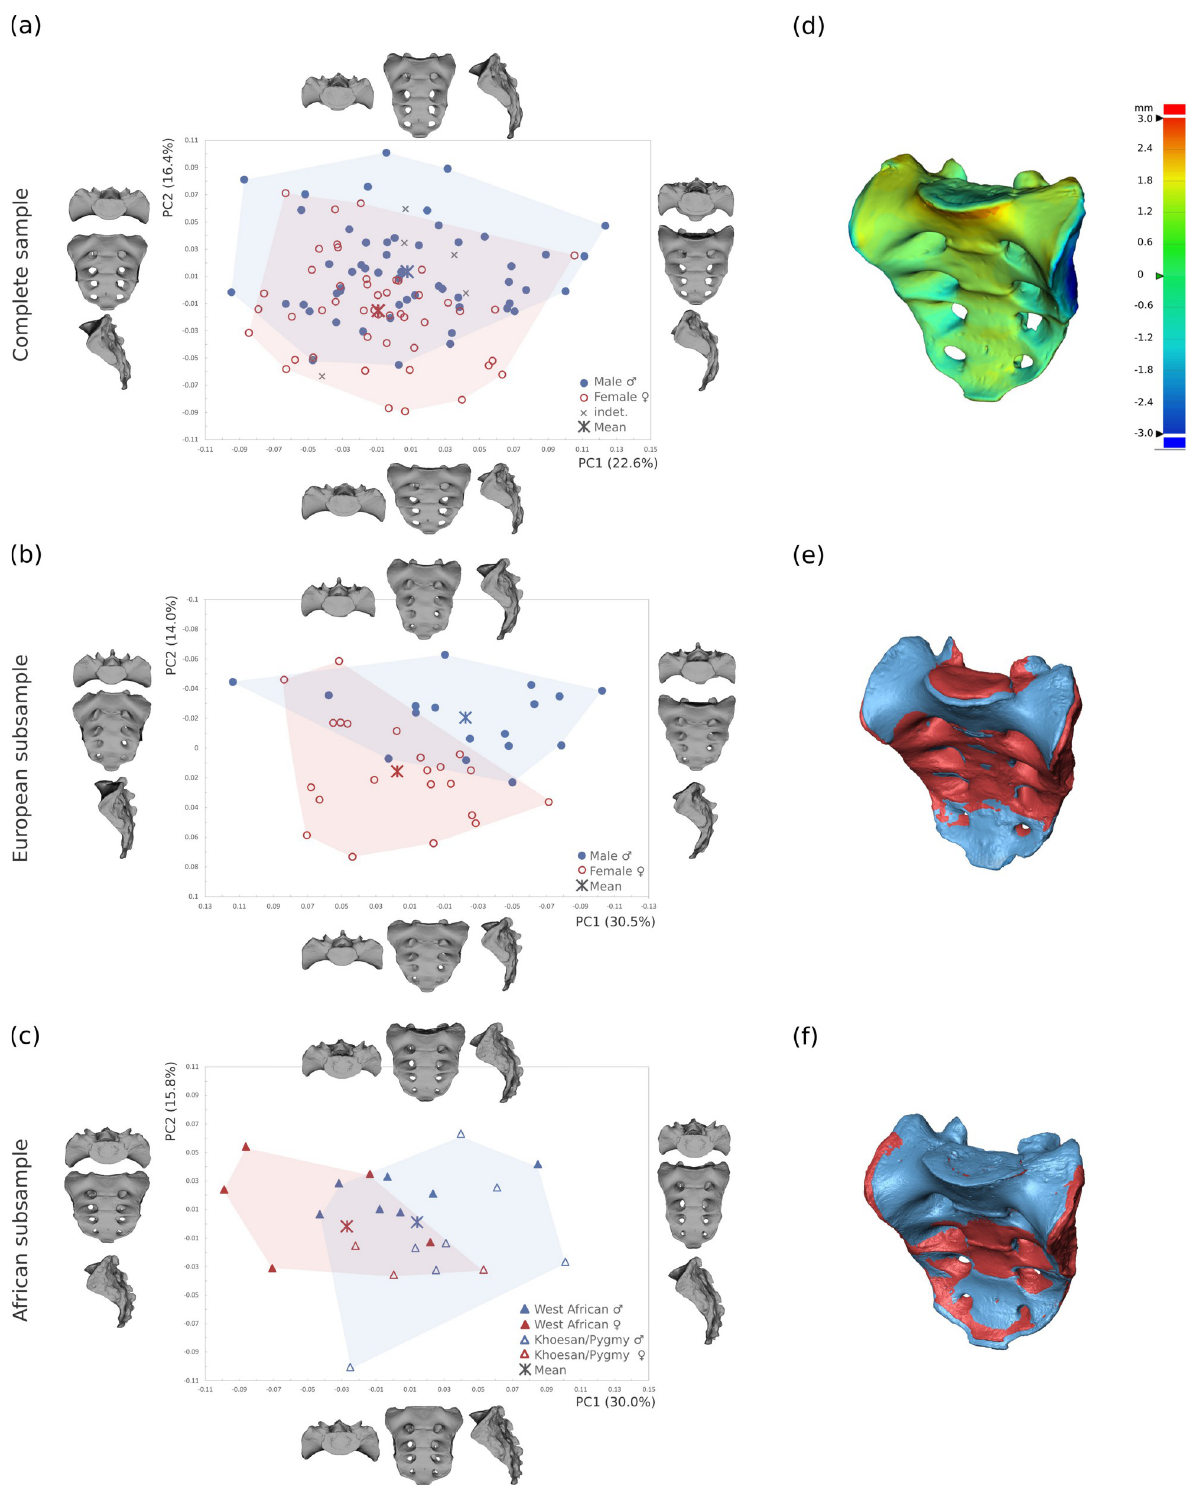
Fig 2. PCA plots of the Procrustes shape coordinates (PC1 vs. PC2). PCA plot of (a) the complete sample (n = 107), (b) the European subsample (n = 39), and (c) the African subsample (n = 23). The thin-plate-spline warps represent the real shape variation at the extremes of the ranges of variation. (d) Colour-coded representation of the morphology changes from the female into the male mean shape of the entire sample. Warm colours indicate a positive deviation, cold colours denote a negative deviation. Superimposed male (blue) and female (red) mean shapes in the (e) European and (f) African